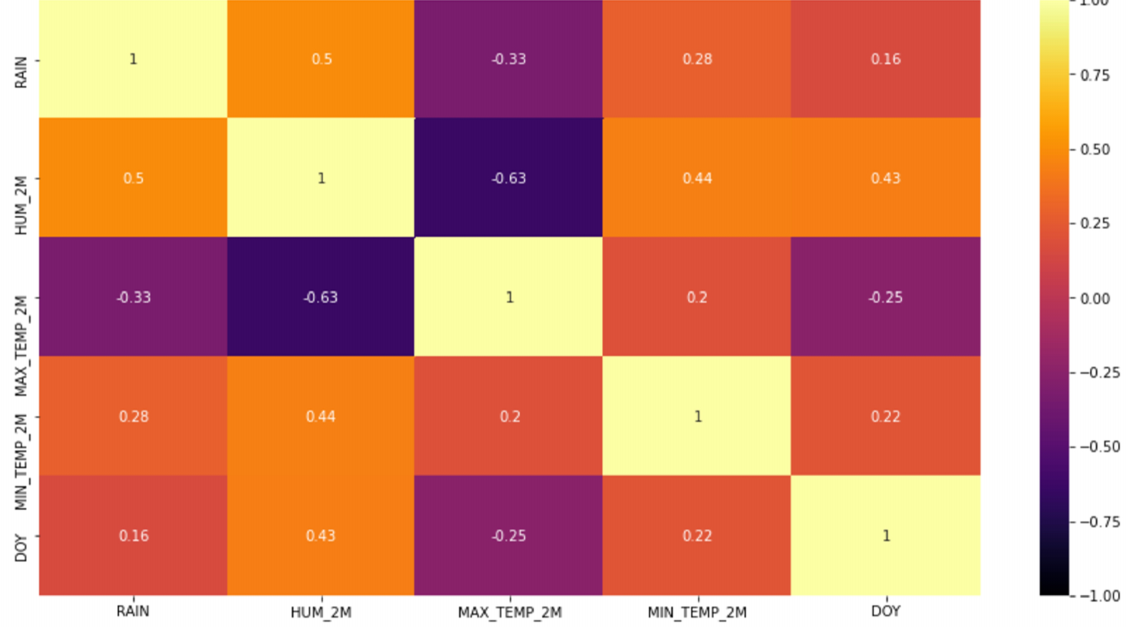
Figure 12. Correlation summary for Rainfall, Relative Humidity, Maximum Temperature, Minimum Temperature and Day of